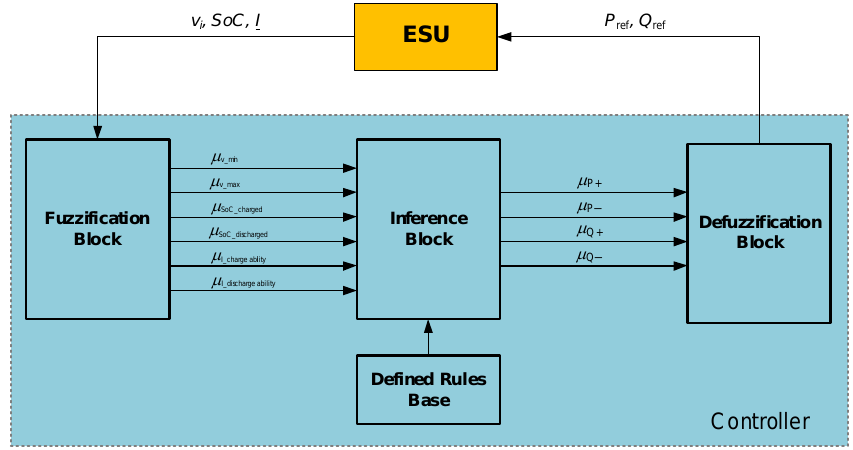
Figure 3. The scheme of a fuzzy controller for the ESU.